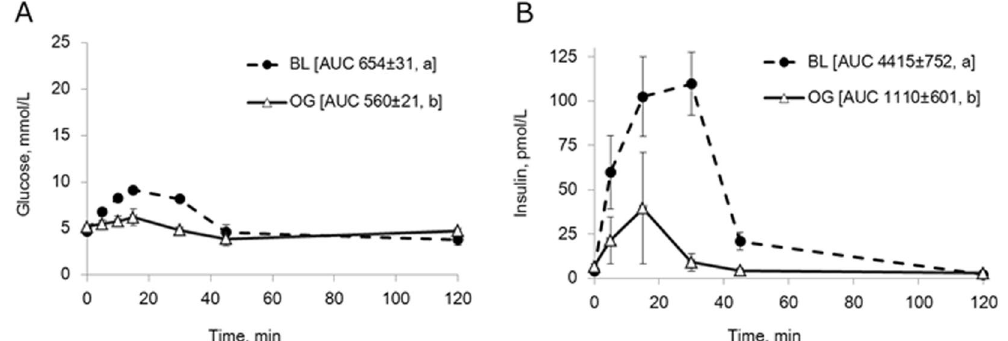
Figure 5. ( A , B ) Blood glucose ( A ) and plasma insulin ( B ) concentrations during GTT, infusing glucose directly into the biliopancreatic limb (BL), in comparison to an oral glucose challenge (OG), in DJB pigs. Data shown as mean ± SEM (n = 4) with AUC values shown in brackets. Different letters indicate statistically significant differences (p < 0.05) between control and